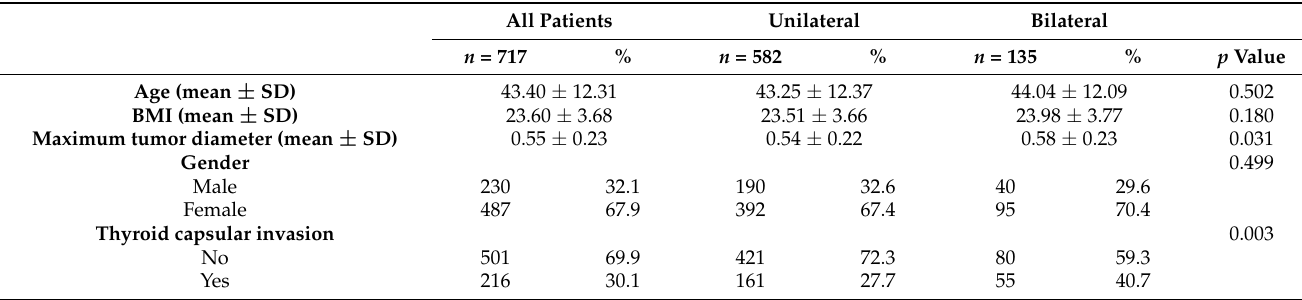
Table 1. The clinicopathological characteristics of patients with PTMC. All